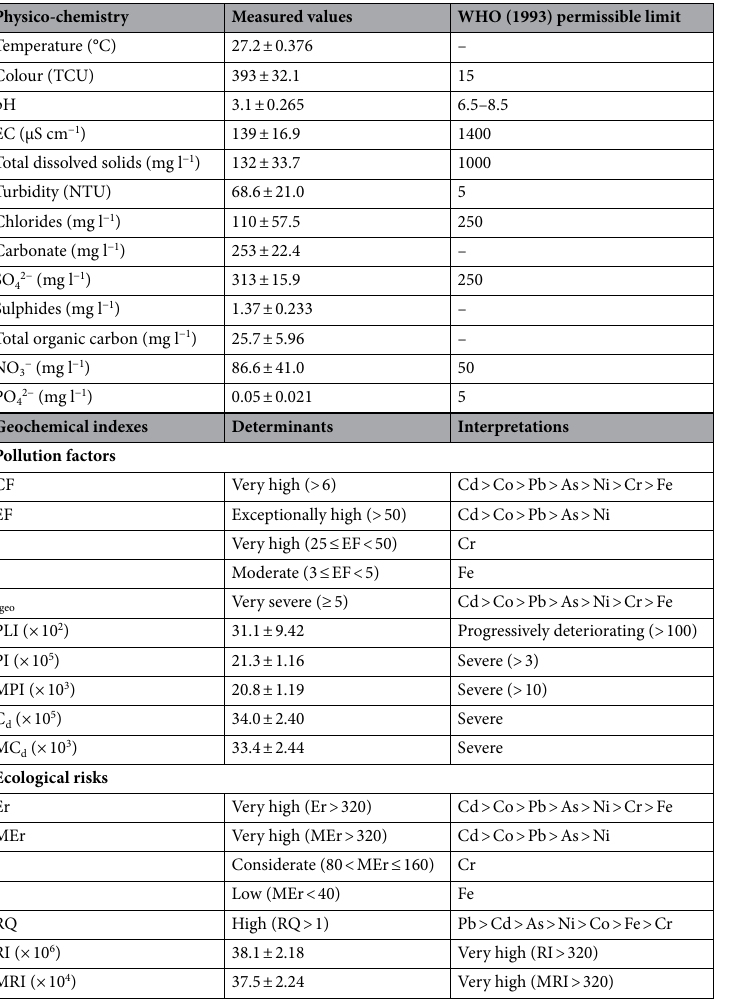
Table 1. Physico-chemistry, pollution and ecological impact determinants of heavy metals and metalloid contained in the AMD from coal mine. Values are mean (± SEM) of triplicate sampling measurements. The pollution indexes and ecological risk assessment factors include: contamination factor (CF), enrichment factor (EF), geo-accumulation index (I geo ), pollution load index (PLI), pollution index (PI), modified pollution index (MPI), degree of contamination (C d ), modified degree of contamination (MC d ), potential ecological risk factor (Er), modified potential ecological risk factor (MEr), potential ecological risk index (RI), modified potential ecological risk index (MRI), risk quotient